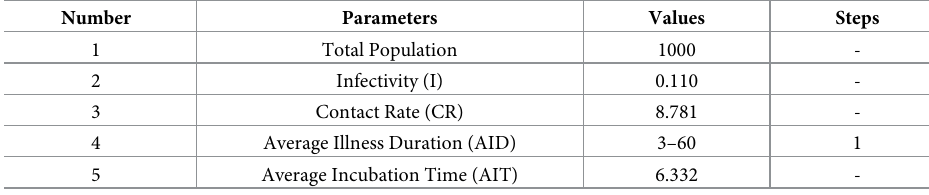
Table 6. Parameter values in the sensitivity analyses